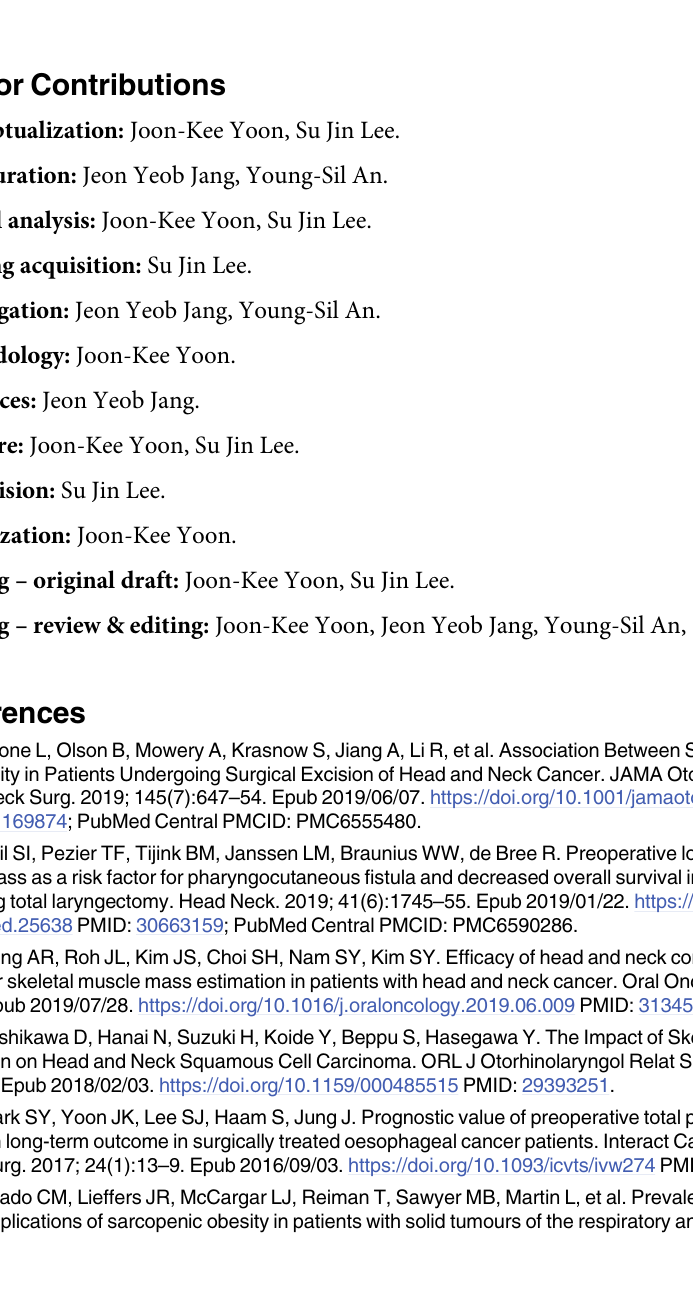
S1 Fig. Association between the skeletal muscle mass at L3 and that at C3 using interna- tional cut-off for sarcopenia. S2 Fig. Association between the skeletal muscle index at L3 and that at C3 using interna- tional cut-off for sarcopenia. S1 Table. Correlation between actual SMM and predicted SMM at L3 using International cut-off for